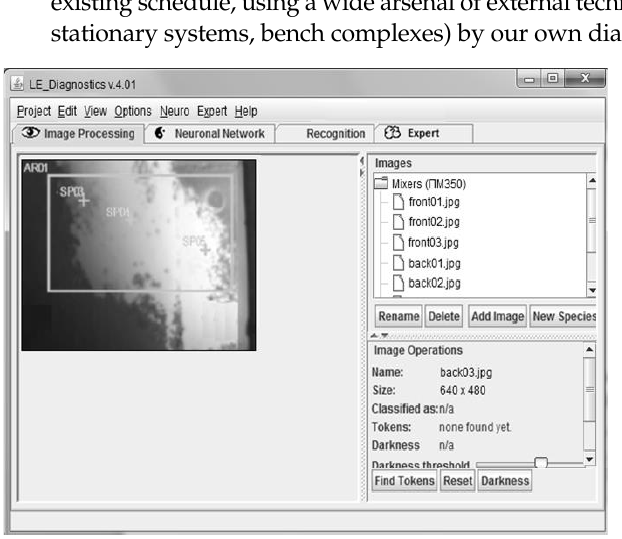
Figure 4. Developed specialized software to diagnose torpedo ladle cars (image processing win- dow).